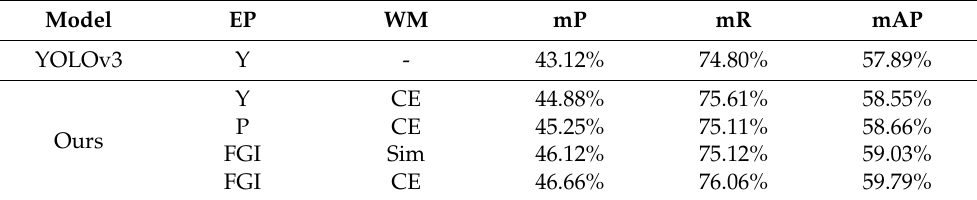
Table A2. Comparison of different extraction points and different the measure.